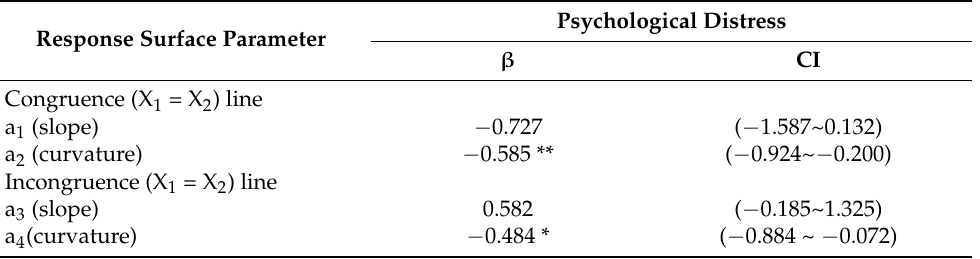
Table 5. Response surface parameters of resilience and family support in the prediction of psychological distress.